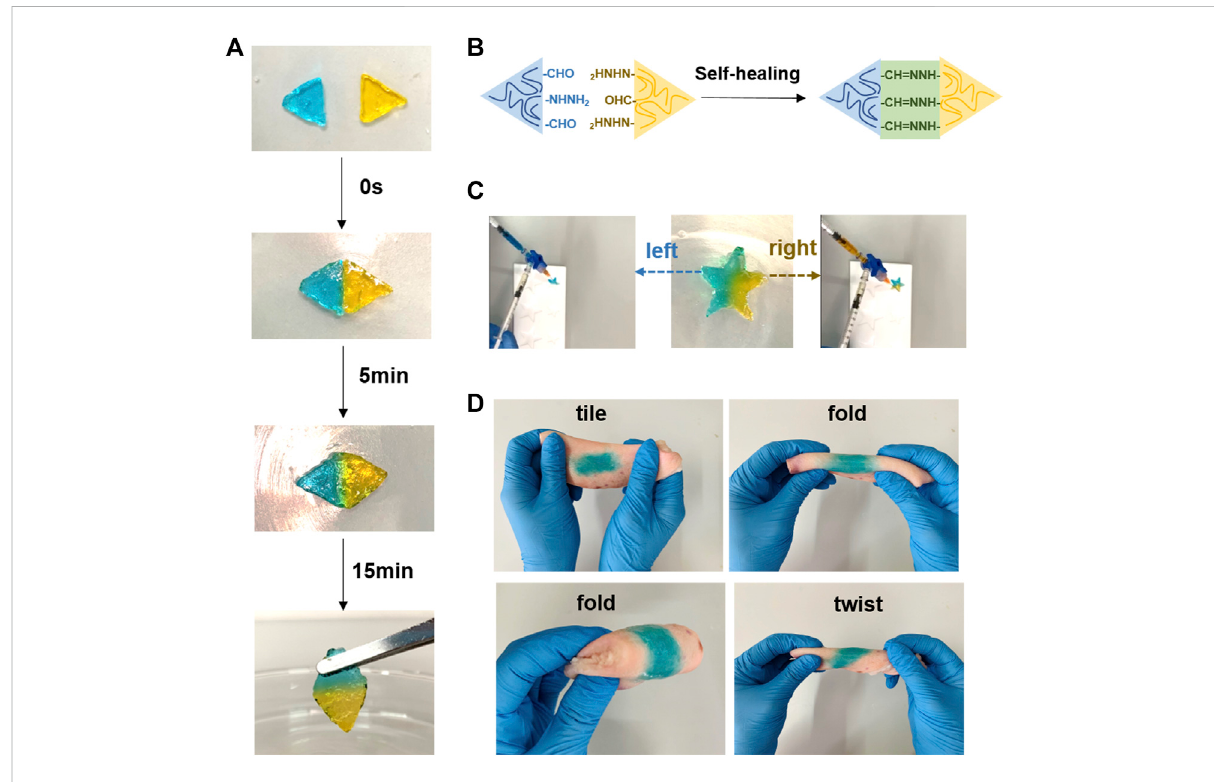
FIGURE 5 Self-healing, injection, and adhesion performance of the OCS/HA-HClO hydrogels. (A) Photo illustration of the self-healing process. (B) Schematic of self-healing of the OCS/HA-HClO hydrogels. Photo illustration of (C) injection and (D) adhesion of